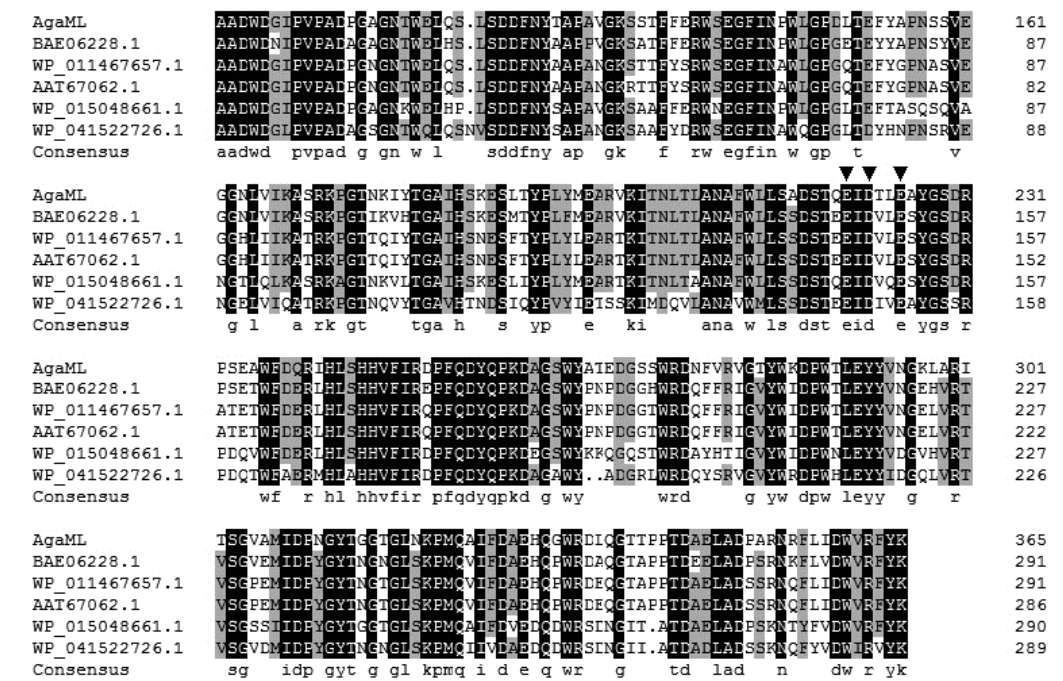
Figure 2. Multiple sequence alignments of the catalytic domain in AgaML with other known β -agarases belonging to glycoside hydrolases family 16 (GH16). BAE06228.1: β -agarase from Microbulbifer agarilyticus JAMB A3; WP_011467657.1: β -agarase from Saccharophagus degradans ; AAT67062.1: β -agarase from Saccharophagus degradans 2-40; WP_015048661.1: β -agarase from Simiduia agarivorans ; WP_041522726.1: β -agarase from agarase Gilvimarinus agarilyticus . The predicted active site residues of AgaML (Glu-220, Glu-225 and Asp-222) are represented as solid inverted triangle symbol.